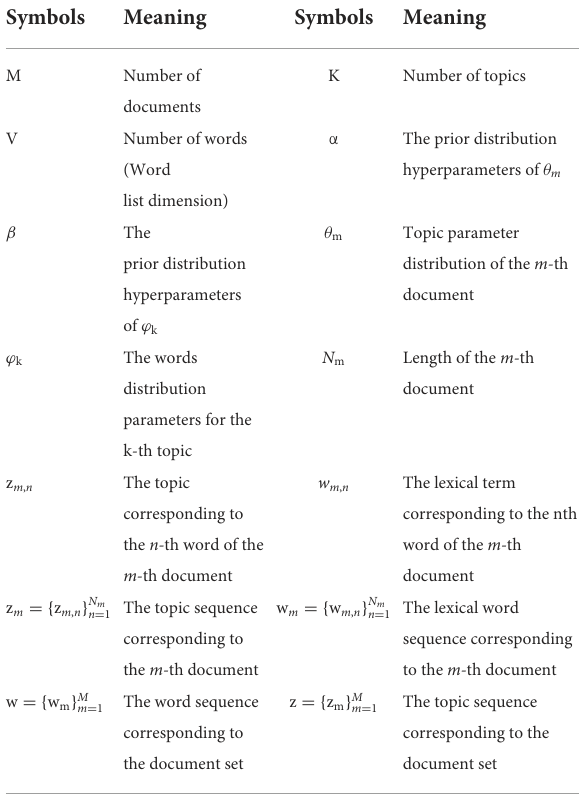
TABLE 1 Explanation of the parameters in LDA topic model probability